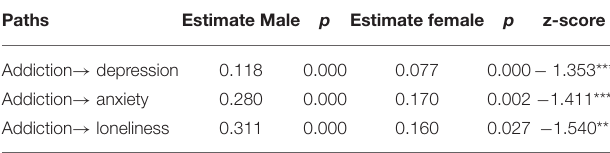
TABLE 2 | Multi-group (male and female) analysis on the relationship among mobile game addiction and depression, social anxiety, and loneliness. Paths